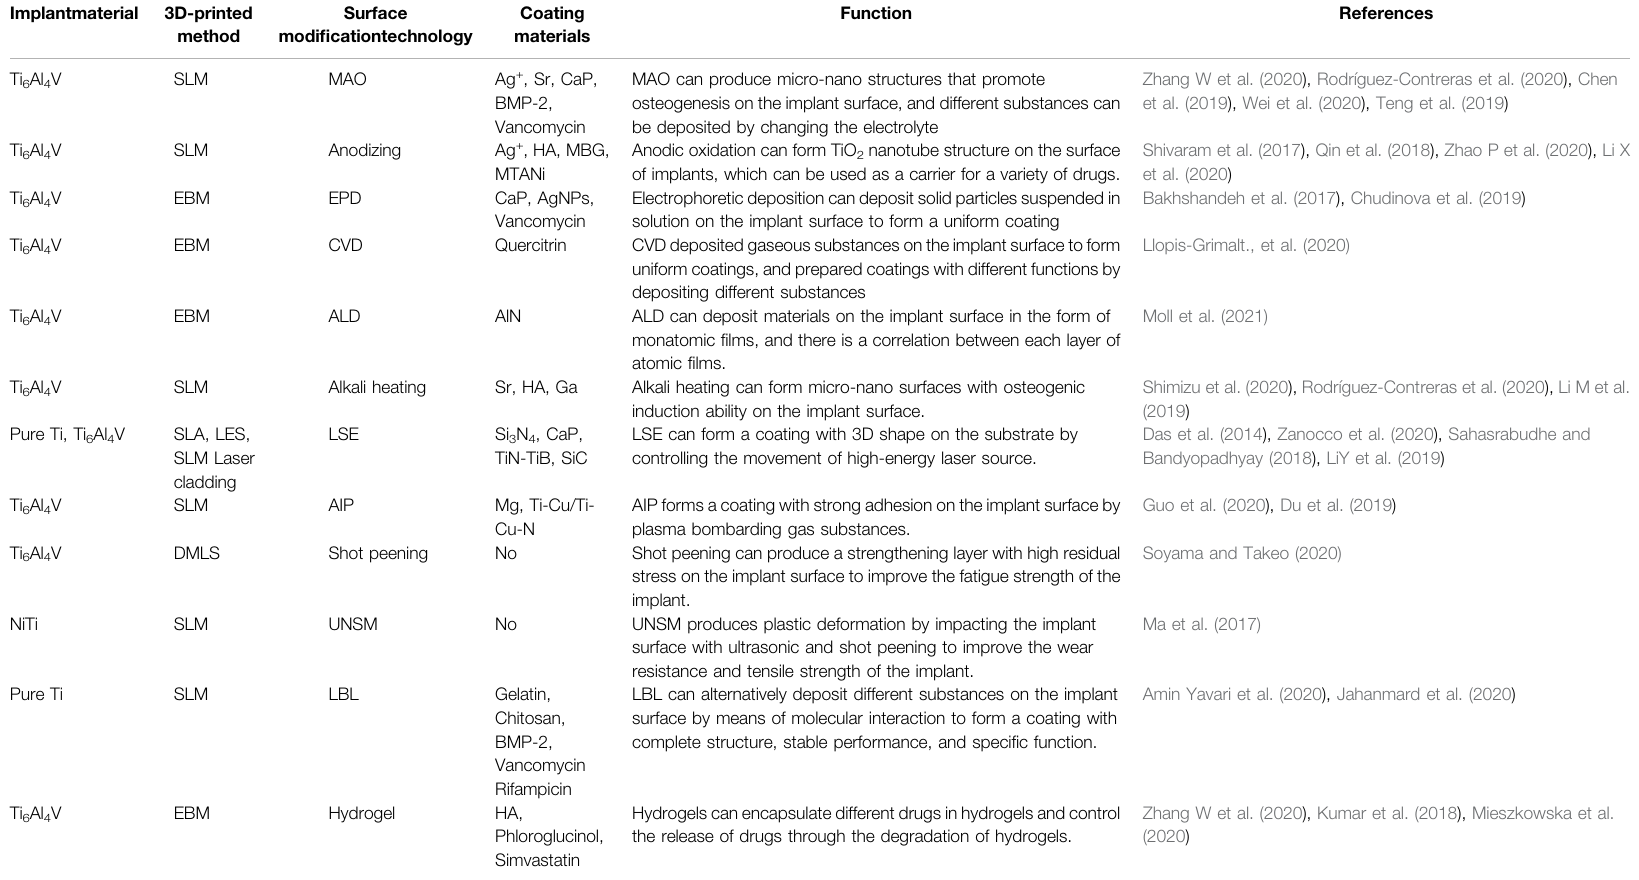
TABLE 3 | Summary of surface modi fi cation technology, coating constructing methods, and functions.